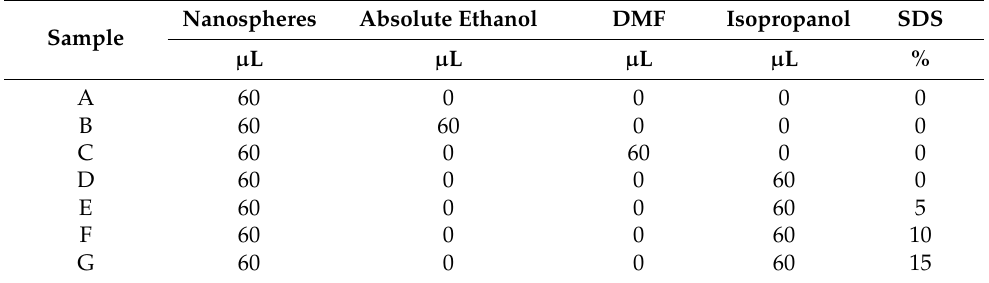
Table 1. Specific reagent doses of each